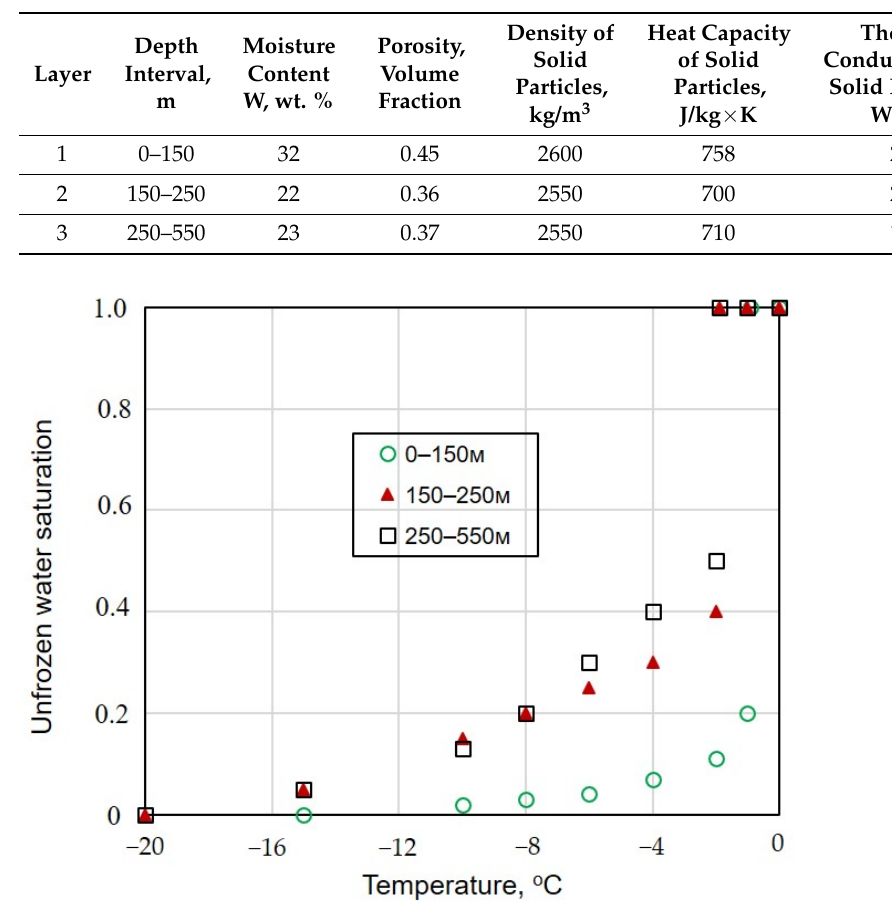
Figure 2. Temperature dependence of unfrozen water saturation ( θ w ) in three